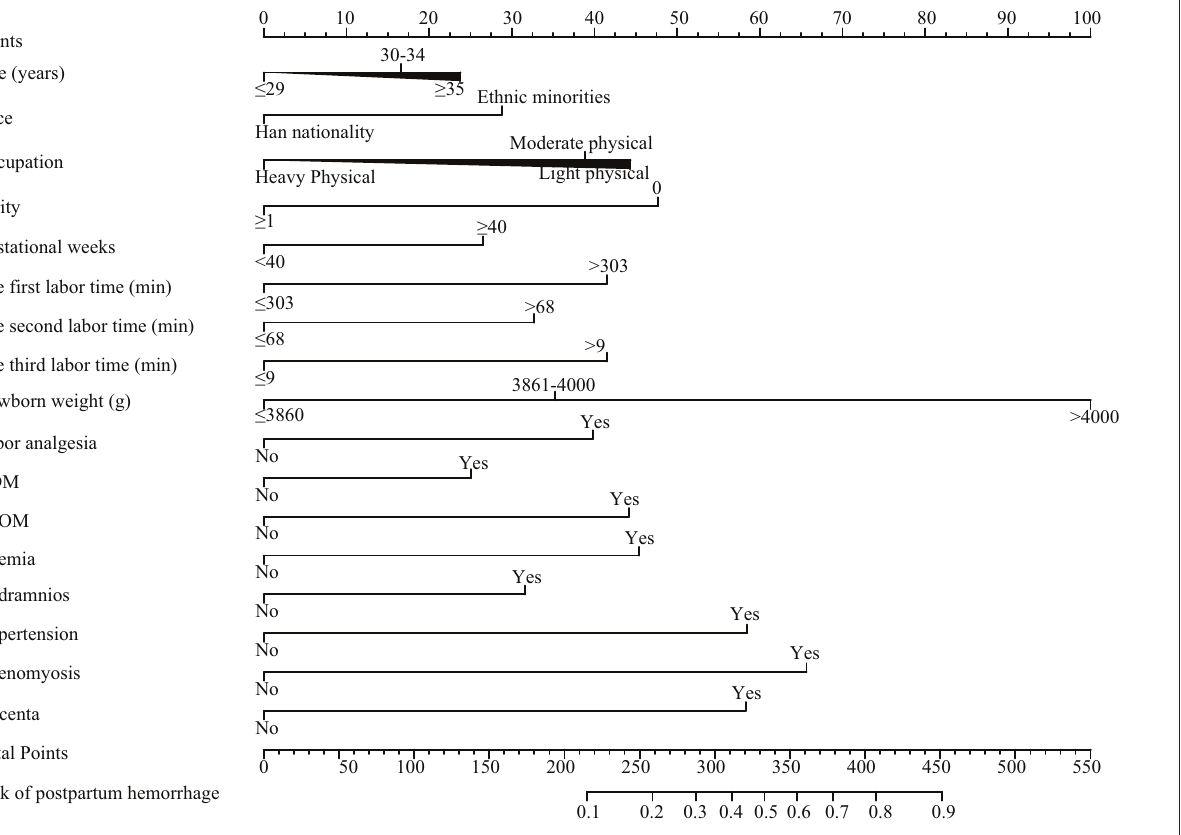
FIGURE 1 | Nomograms for postpartum hemorrhage. GDM, gestational diabetes mellitus; PROM, premature rupture of membranes.